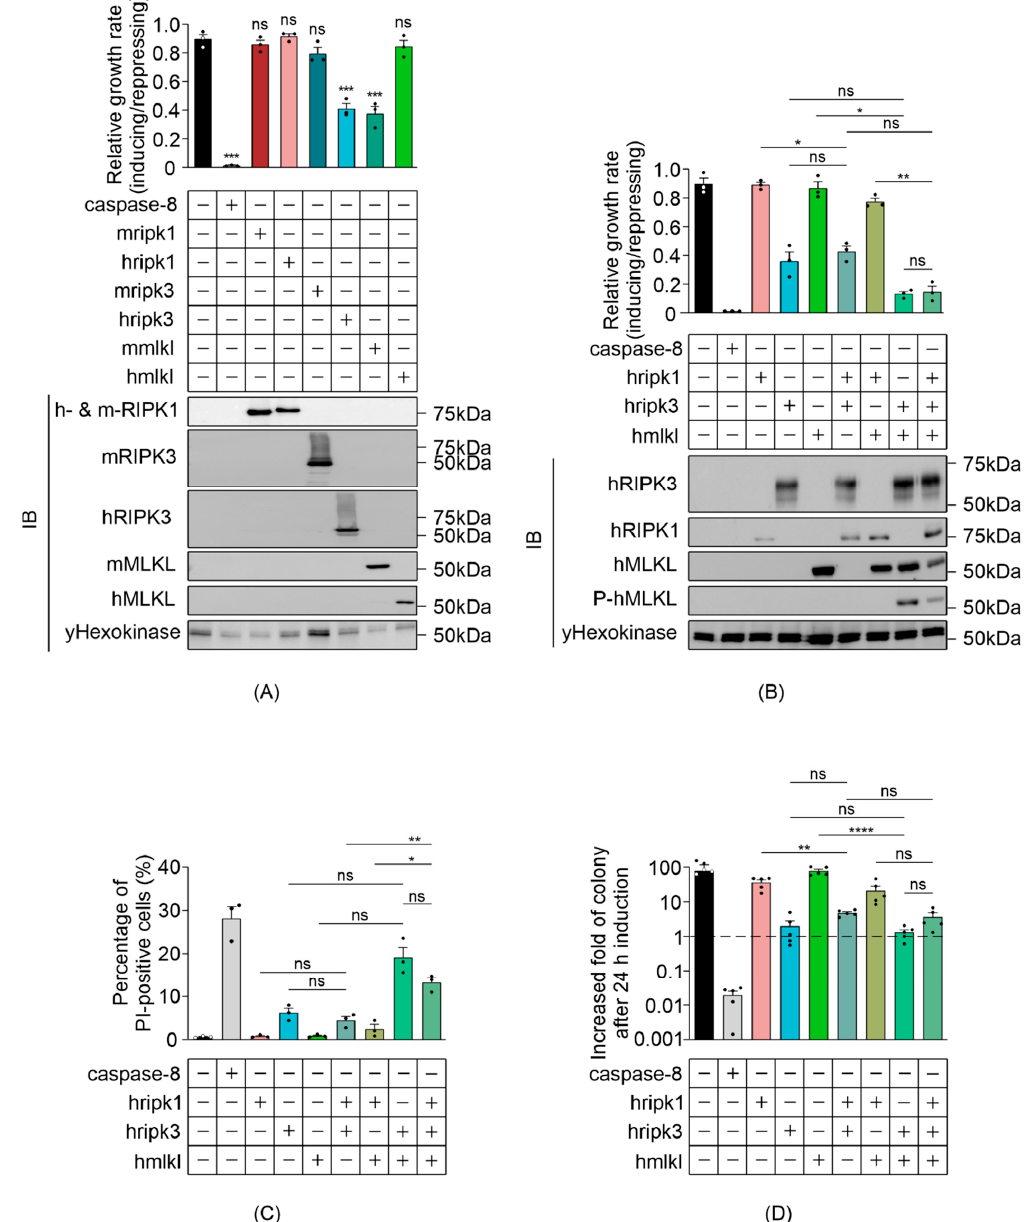
Figure 1. Reconstitution of necrosome interaction in S. cerevisiae . Maximal growth rates of yeast bearing expression plasmids encoding ( A ) single murine or human, or ( B ) human wild type necroptotic effector(s), were analyzed by monitoring changes in absorbance of yeast cultured in inducing and repressing liquid media. Expression of recombinant protein(s) were assessed by Western blot. Loading control: anti-hexokinase. ( C ) Yeast bearing expression plasmids encoding human necroptotic effector(s) were grown under inducing conditions for 24 h. Following galactose removal, plasma membrane integrity of each yeast culture was assessed by propidium iodide (PI) uptake. ( D ) The colony-forming abilities of post-induction cultures were expressed relative to the corresponding uninduced cultures. Cells were grown in inducing media for 24 h. Following galactose removal, the post-induction cultures were diluted and plated on solid repressing media and incubated for 2 days. Data present mean ± SEM of three independent assays in ( A – C ) and five independent assays in ( D ). Differences in growth rates of ( A ) empty vector yeast versus those expressing each transgene, or ( B – D ) sets of 2–3 transgenes versus individual transgenes or pairs of transgenes were compared using ANOVAs with Sidak corrections. *, p < 0.05; **, p < 0.01; ***, p < 0.001; ****, p < 0.0001; ns, not